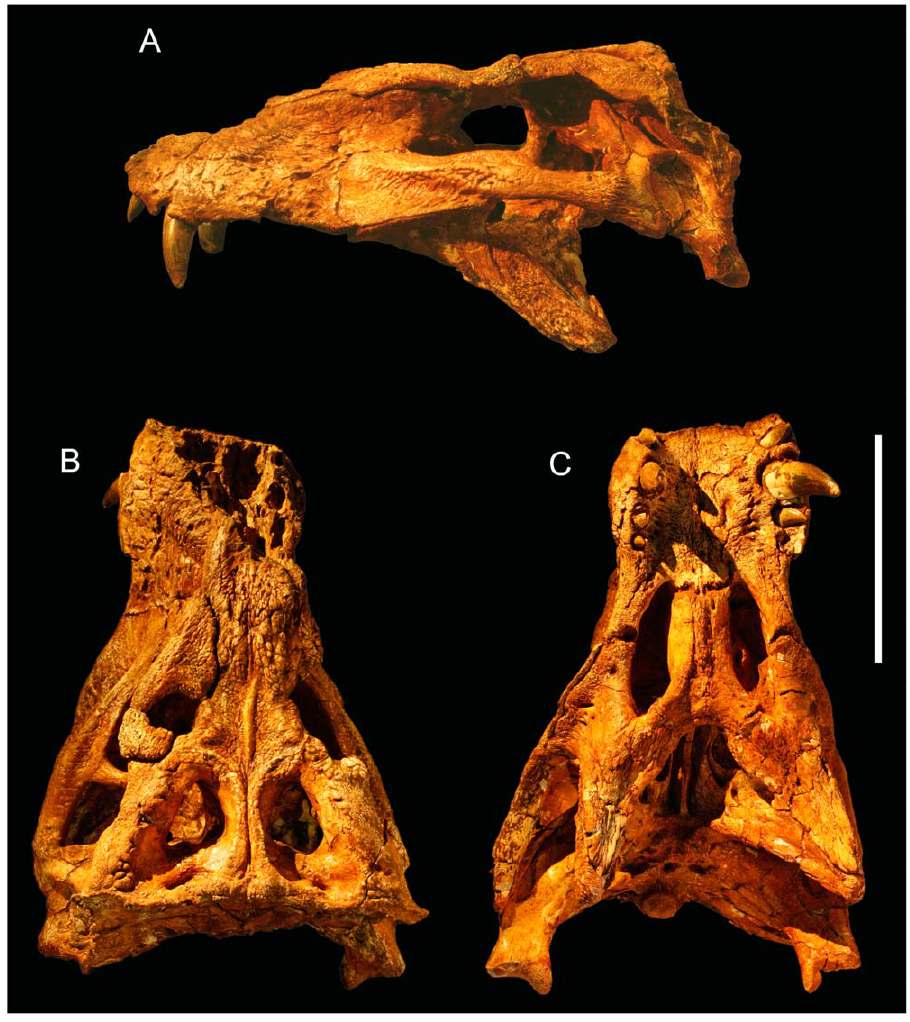
Figure 3. Skull of the baurusuchid Pissarrachampsasera (LPRP/USP 0019, holotype). A) lateral; B) dorsal; C) ventral views. B and C have depth of field calibrated to the skull table and palatal plane respectively. Scale bar equals 10 cm.